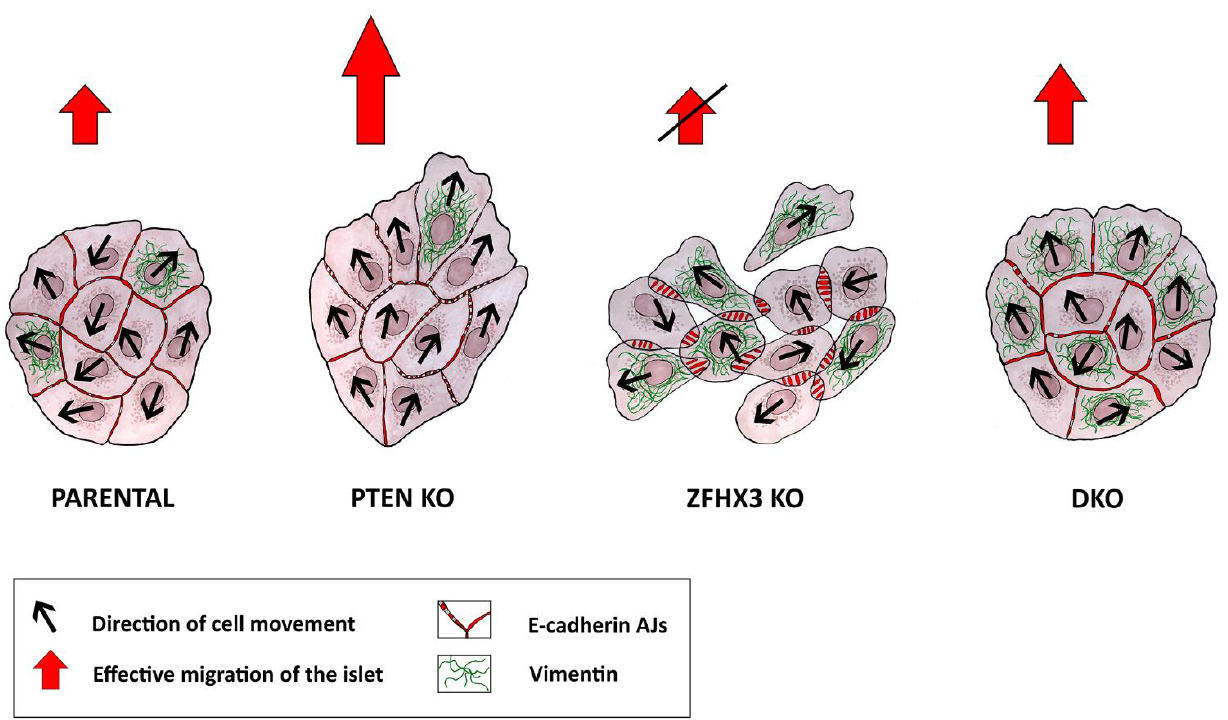
Figure 6. Plasticity of migration modes of genetically edited MCF10A cell lines. Knockouts of different TSGs induced partial EMT of different stages, which was associated with reorganization of AJs. MCF10A parental cells showed well-defined linear (tangential) AJs and demonstrated limited cell motility of islets. PTEN knockout was accompanied by the appearance of punctuated AJs followed with enhanced coordinated collective migration of epithelial islets. ZFHX3 knockout resulted in the appearance of radial AJs and increased expression of the mesenchymal marker vimentin, which led to the weakening of cell–cell contacts and was accompanied by the loss of coordination of cell movement in islets and, as a result, a decrease in the efficiency of cell migration. DKO cells exhibited a different motile state, intermediate in terms of collective migration, characterized by a combination of linear AJs and high levels of